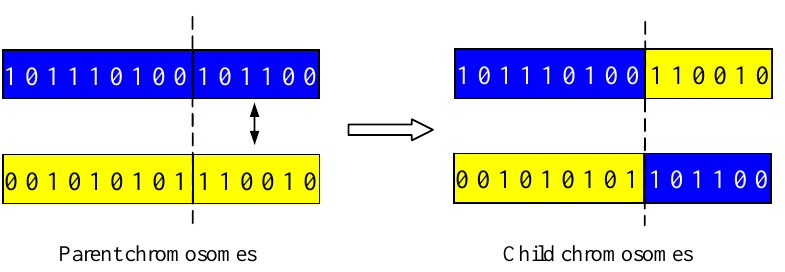
Fig 2: Crossover of binary chromosomes.